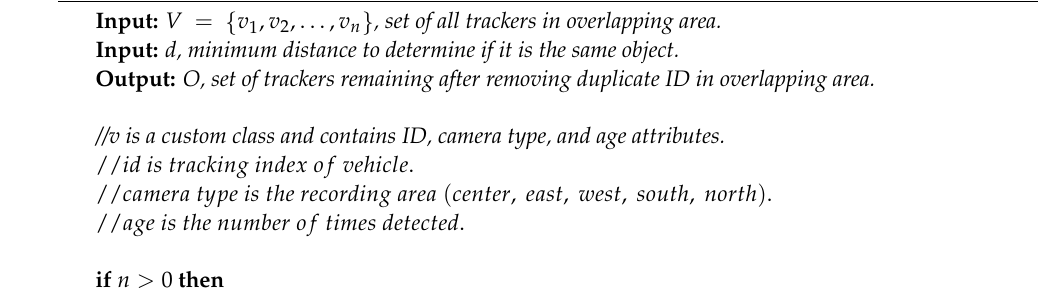
Algorithm 1. Overlapping vehicle matching on the ground plane